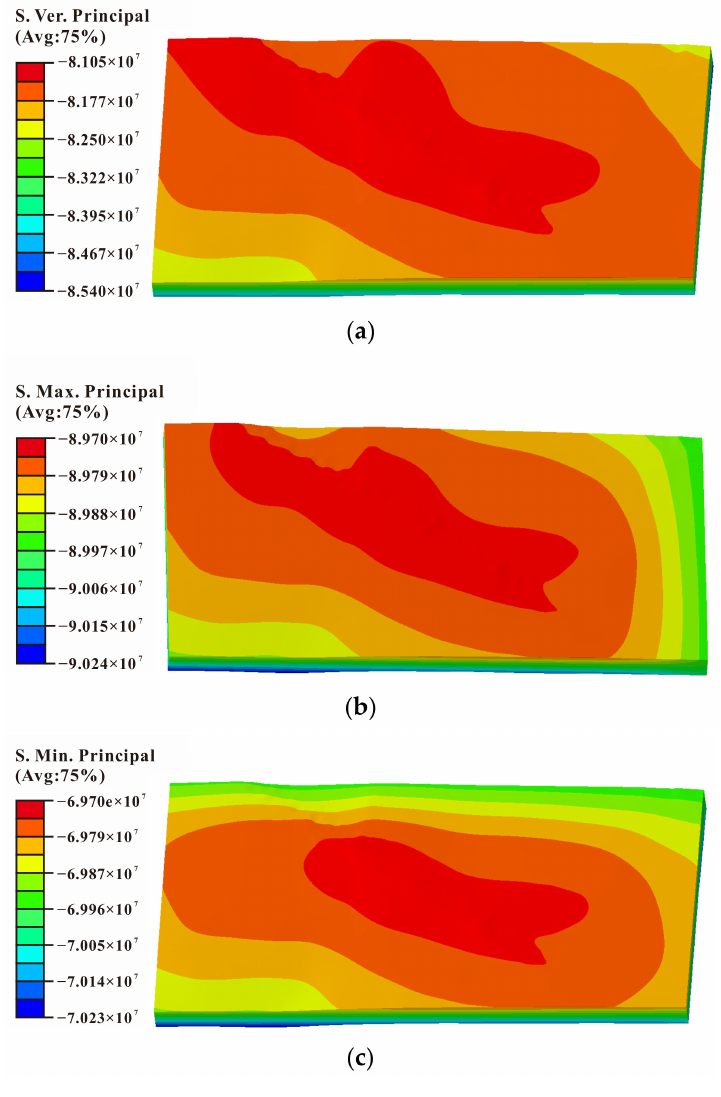
Figure 7. Simulation results of distribution of three principal stresses. ( a ) Vertical principal stress. ( b ) Maximum horizontal principal stress. ( c ) Minimum horizontal principal